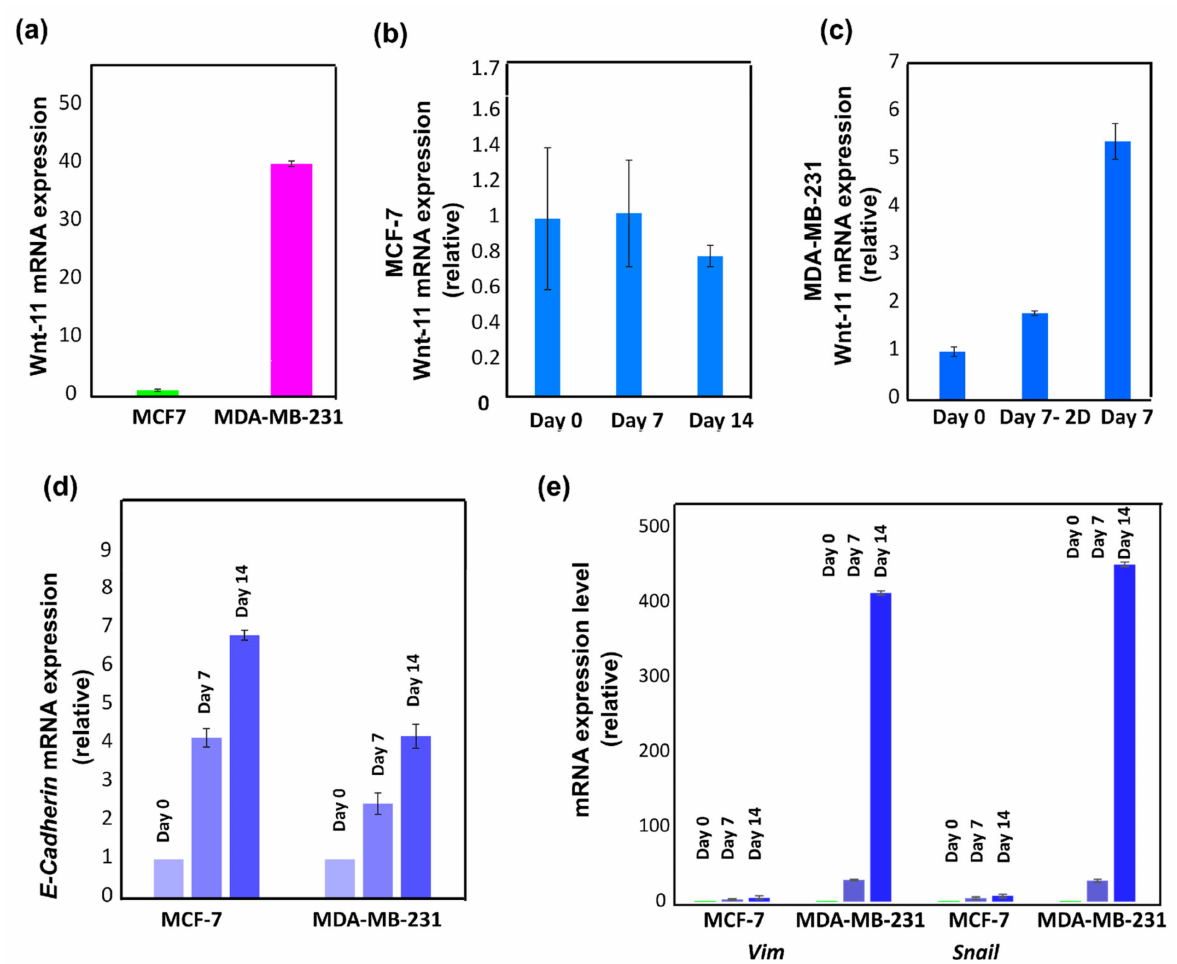
Figure 6. ( a ) qRT-PCR analysis of Wnt-11 expression level in MCF7 and MDA-MB-231 cells cultured in 3D PHA scaffolds. ( b ) Wnt-11 mRNA levels in MCF7 cells cultured in 3D PHA scaffolds for 0, 7 and 14 days. ( c ) Wnt-11 mRNA expression levels in MDA-MB-231 cells cultured on 3D PHA scaffolds for 0, 7 and 14 days. ( d ) E-Cadherin mRNA expression levels in MCF7 and MDA-MB-231 cells cultured in 3D PHA scaffolds for 0, 7 and 14 days. ( e ) mRNA levels of Vim and Snail in MCF7 and MDA-MB-231 cells grown in 3D PHA scaffolds. The column graphic represents the average of three replicates of mRNA isolated from each cell line. The data are normalised according to RPII expression level by fold analysis ( n = 3; p <